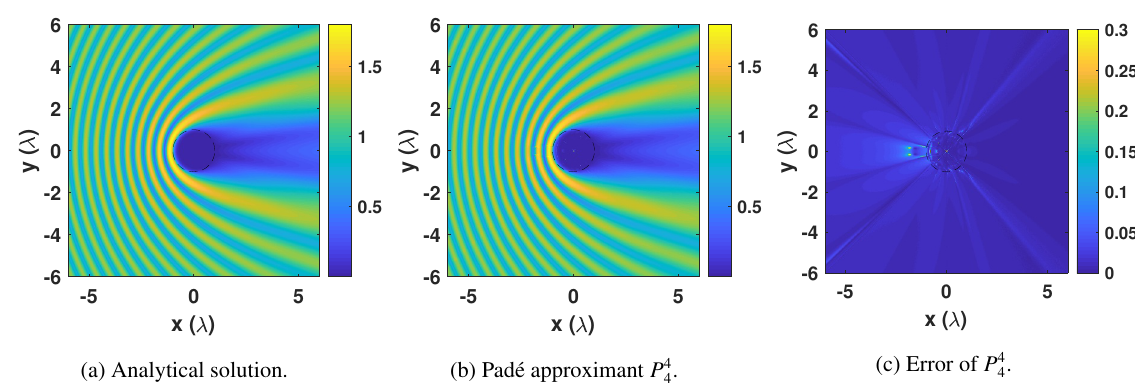
Figure 1: Padé approximation in the two-dimensional problem of a cylinder on which a unit plane wave impinges under normal incidence. The cylinder has a radius of 1 λ and has the permittivity of silver ε r = − 4 . 42 + 0 . 201 i , which is a case that is well outside the weak-scattering regime. The approximant that is shown is P 4 N = 4, which was found to give the best approximation to the actual